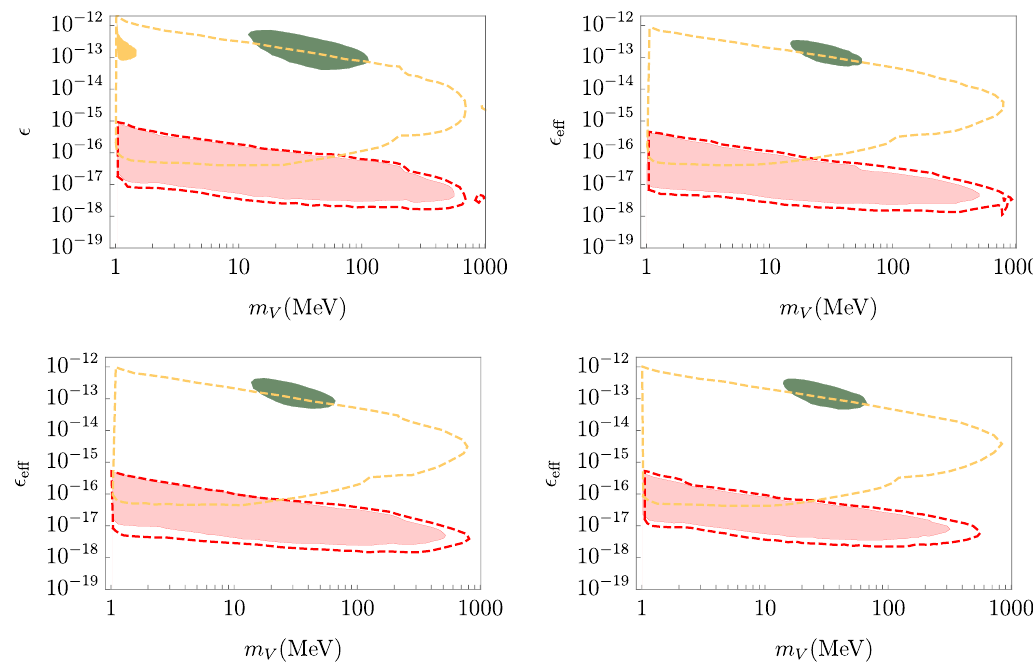
Figure 6 . Cosmological limits on dark vectors from electromagnetic energy injection as a function of the dark vector mass m V and e(cid:11)ective coupling (cid:15) e(cid:11) assuming a thermal freeze-in abundance. The dark vector varieties shown are a dark photon (upper left), B (cid:0) L (upper right), L e (cid:0) L (cid:22) (lower left), and L e (cid:0) L (cid:28) (lower right). The shaded green regions indicate the exclusions from BBN due to photodissociation, the shaded red regions show the exclusion from the CMB power spectrum measured by Planck, the dashed red contours indicate the projected limits for a cosmic variance limited experiment, the solid yellow region shows the exclusion from CMB frequency spectrum distortions in COBE/FIRAS, and the dashed yellow contours give the projected sensitivity to such distortions at